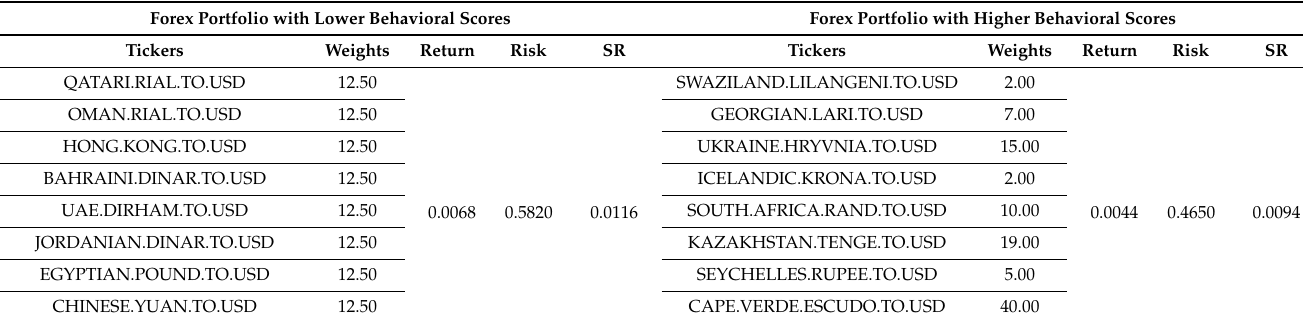
Table 9. Optimization results for Forex portfolios using the CBMV approach. Forex Portfolio with Lower Behavioral Scores